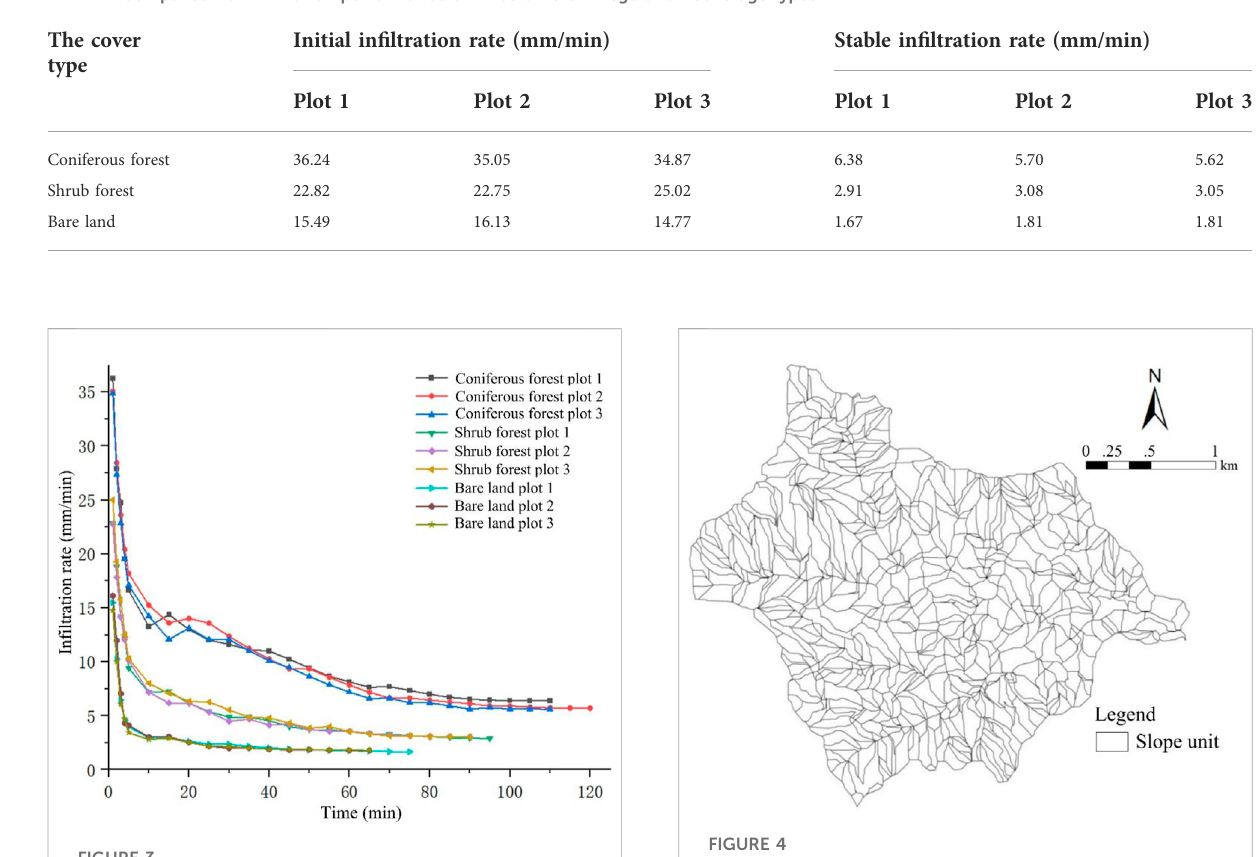
FIGURE 3 In fi ltrationprocessofdifferentvegetationcoverageingranite residual soil in South China.